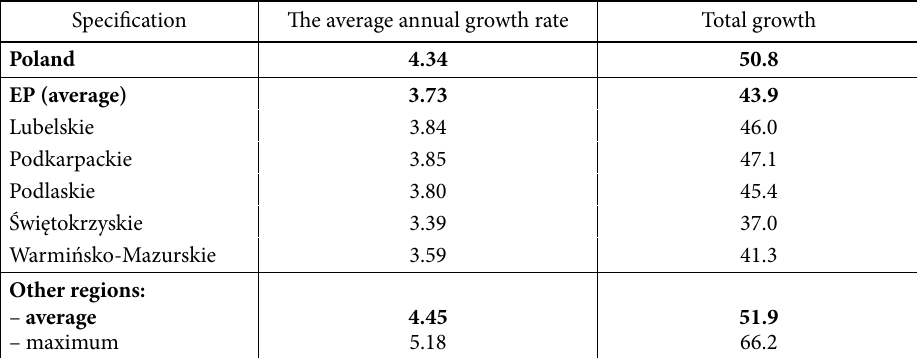
Table 3. The growth rate of GDP per capita in 2004–2015 (constant prices, 2000 = 100) (source: own calculations based on CSO data) Specification